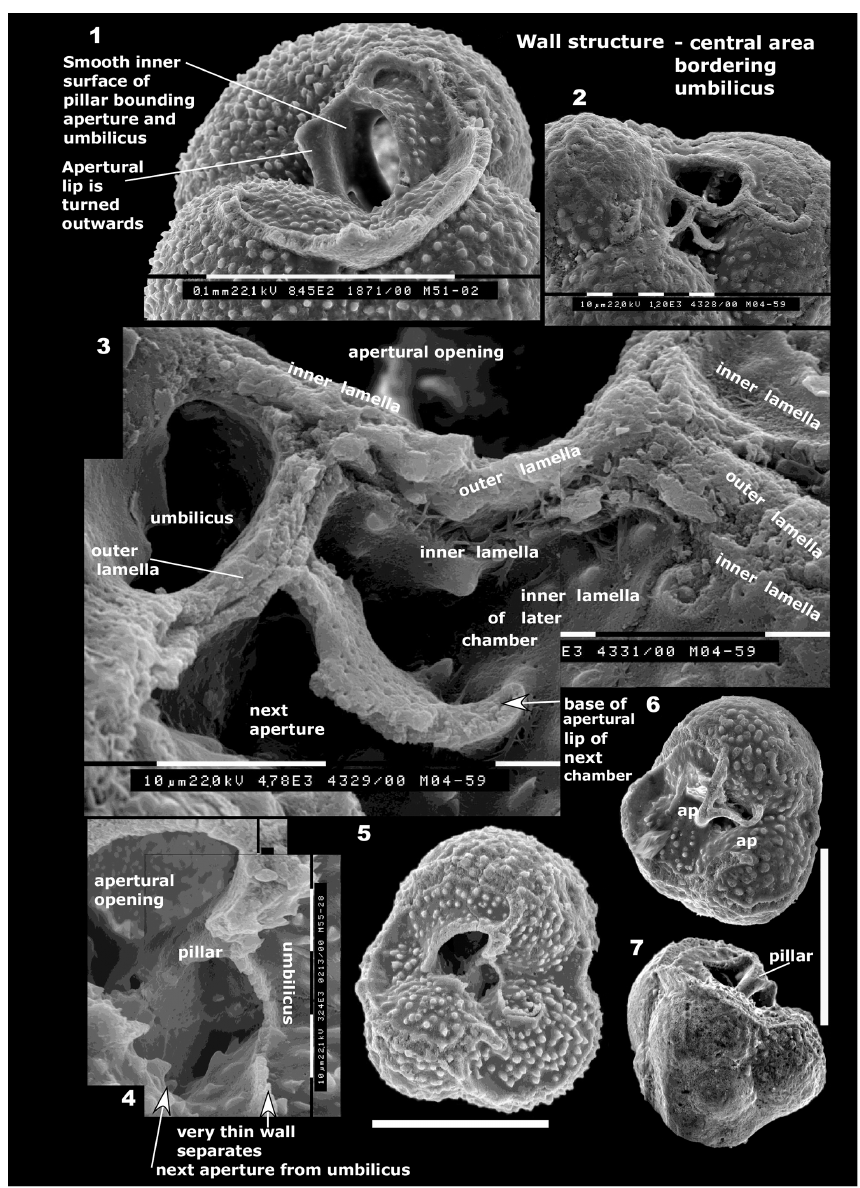
Figure 9. (1) Wall structure in central area bordering umbilicus. Globuligerina altissapertura n. sp., specimen WAM 18.9/M51-02. The broken apertural lip of the final chamber forms a pillar-like structure, contiguous with older apertures. The inner surface of this structure is smooth in this specimen, and the lip is turned outwards (see also Fig. 6: 1–2 for additional photos of the same lip). Scale bar: 100µm. (2–3) Globuligerina altissapertura n. sp., specimen WAM 18.8/M4-59. (2) Umbilical view of part of broken, naturally etched specimen, showing the aperture and scars of the walls of two broken-off chambers; (3) detail of (2) . The septum at right between the two broken chambers consists of three layers: inner, outer and inner lamella. Note the inner lamella lining the floor of both chambers. The apertural lip of the earlier aperture (at top) is badly damaged, and the turnover of the lip into the umbilicus is not seen. A curved plate in the lower part of the photo appears to be the rear portion of attachment of the lip of the following aperture. For (2–3) , each division of scale bar: 10µm. (4–5) Globuligerina bathoniana australiana n. ssp., specimen WAM 18.18/M55-28; (see also Fig. 6: 4–5; Fig. 10: 8–10). (4) Detail of (5) , showing the umbilical structures. Aperture of earlier chamber at upper left; the light colour is an imaging aberration, as the view is into the empty space of the chamber. The dark hollow at lower centre is a blind alley behind the pillar, closed off by the apertural lip. Each division of scale bar: 10µm. (5) Umbilical view; two chambers are broken off. The broken chamber at left has an aperture that opened towards the lower right, and a very thin wall of curving apertural lip separates the chamber from the umbilicus (see (4) ). Scale bar: 100µm. (6–7) Globuligerina bathoniana australiana n. ssp., specimen WAM 18.17/M51-06. (6) Umbilical view of heavily calcified specimen, showing a broken-off chamber, with two successive apertures at 120 ◦ , rotating around the robust hollow central pillar structure; (7) specimen tilted away from viewer to show the pillar in side view; top of the earlier aperture is the dark area to the left of the pillar. The scale bar for (6–7) is